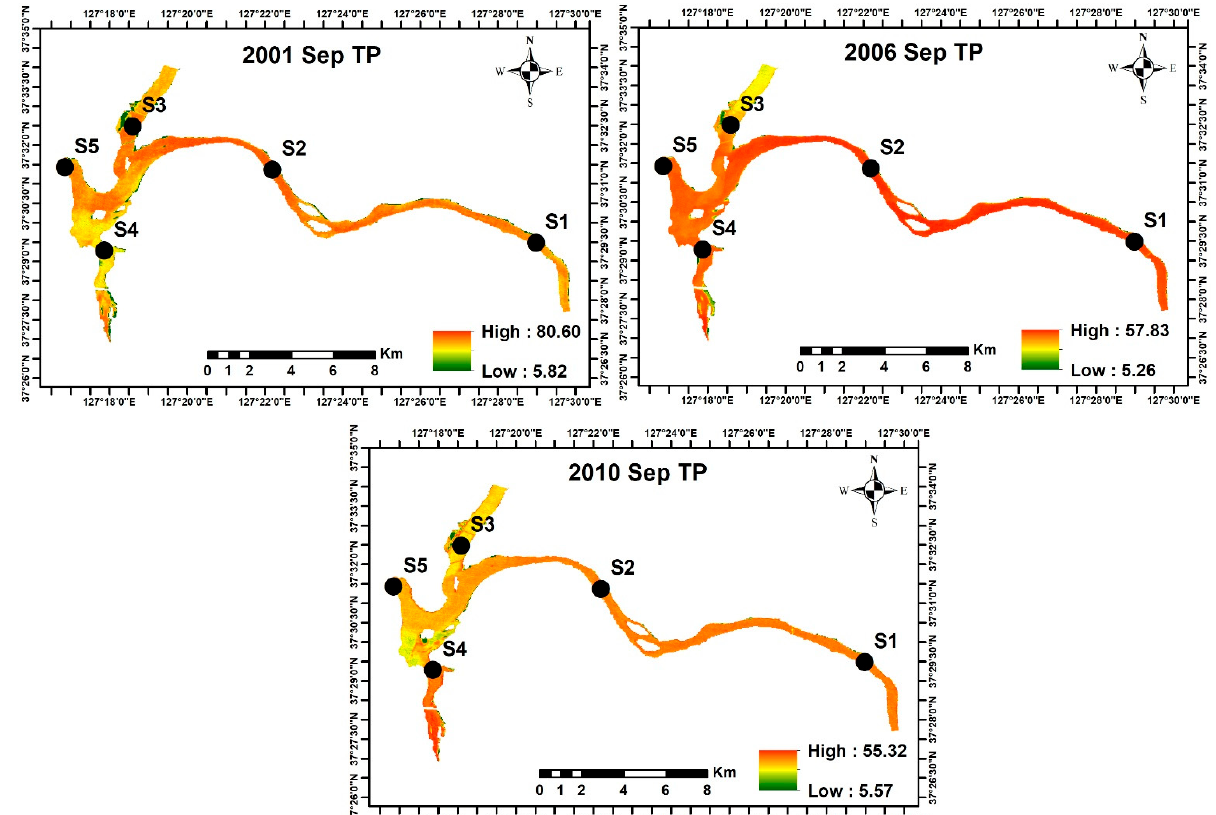
Figure 4. Spatial and temporal pattern of total phosphorus (TP) on September 2001, 2006 and 2010.